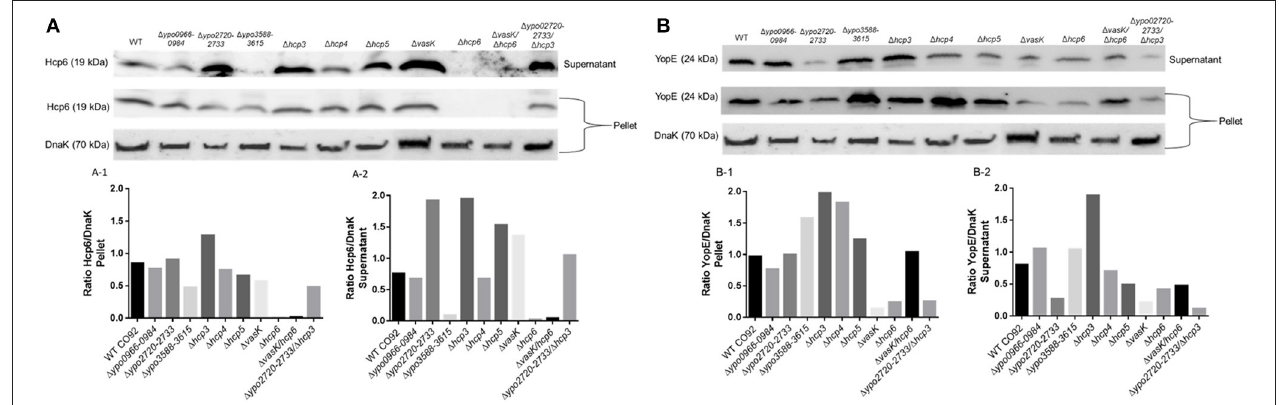
FIGURE 5 | Production of the T6SS effector Hcp6 and the T3SS effector YopE . WT Y. pestis CO92 and the indicated T6SS mutant strains were grown in HIB overnight and subsequently diluted 1:20 in fresh HIB supplemented with 5mM EGTA. Growth was continued at 28 ◦ C for 2h, followed by a temperature shift to 37 ◦ C for an additional 3h of incubation. Bacterial pellets and supernatants were dissolved in SDS-PAGE buffer. Western blot analysis was then performed to detect Hcp6 (A) and YopE (B) in bacterial pellet and supernatant samples. Levels of DnaK in bacterial pellets were utilized as a loading control to ensure similar levels of bacteria were used across all samples examined. Sizes of the proteins are indicated in parentheses. Densitometry scanning was performed by using Image Studio TM Lite Software (Li-Cor Inc., Lincoln, NE) to quantitate expression of Hcp6 and YopE in ratio to DnaK in the pellet (A-1, B-1) and supernatant (A-2, B-2) samples. The same blot was used for analyzing both Hcp6 and YopE as well as DnaK. The experiment was performed twice and typical data from one of the experiments is presented.